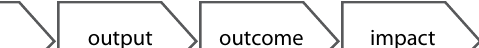
value-creationinput output outcome fig. 3. The elements of